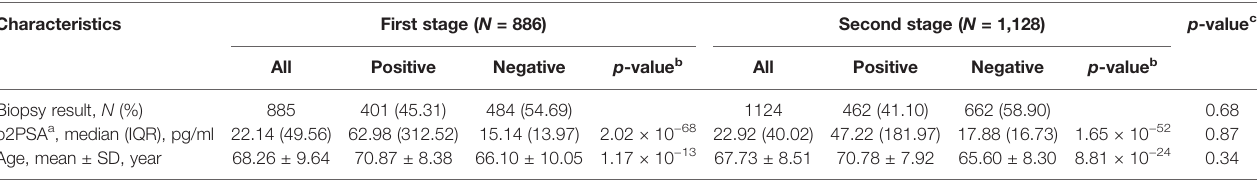
TABLE 1 | Characteristics of the participants in the two